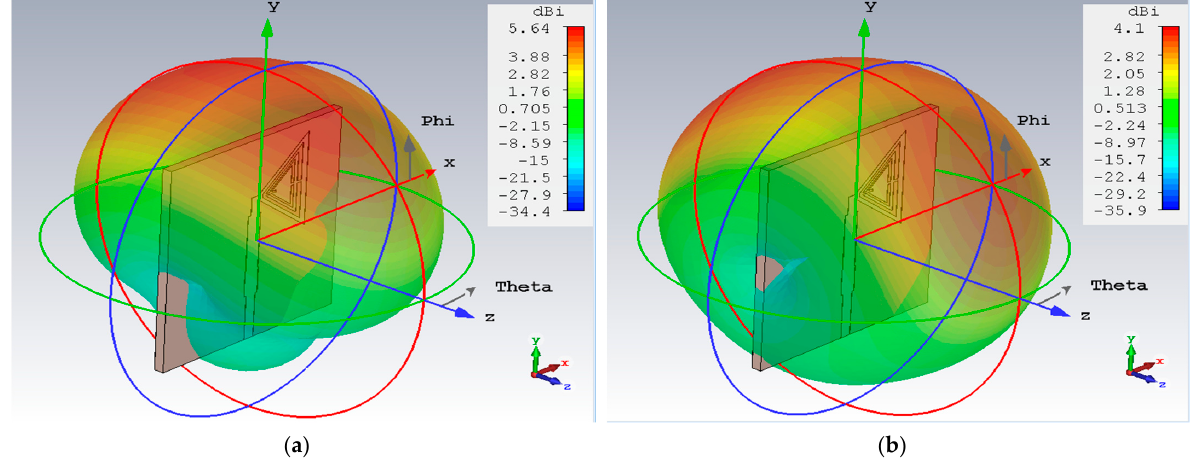
Figure 10. Simulated 3D radiation pattern of the proposed antenna at ( a ) 3.5 GHz and ( b ) 4.9 GHz. The simulated current distribution for the proposed bowtie antenna at the center fre- quencies of 3.5 GHz and 4.9 GHz is shown in Figure 11a,b. This helps to understand the reasons for the dual-band behavior of the antenna. Higher and lower current distributions in the antenna are represented by red and blue, respectively, in Figure 11. As can be ob- served in Figure 11a, at 3.5 GHz, the current was more dominant along the TCSRR of double-sided triangular patches and edges of the modified stepped feedline. The current flows were oppositely directed along the TCSSR edges. According to Figure 11b, at the center frequency 4.9 GHz, the current flows were more dominant around the edges of TCSRR etched from the triangular patch in the ground plane and across the feedline.